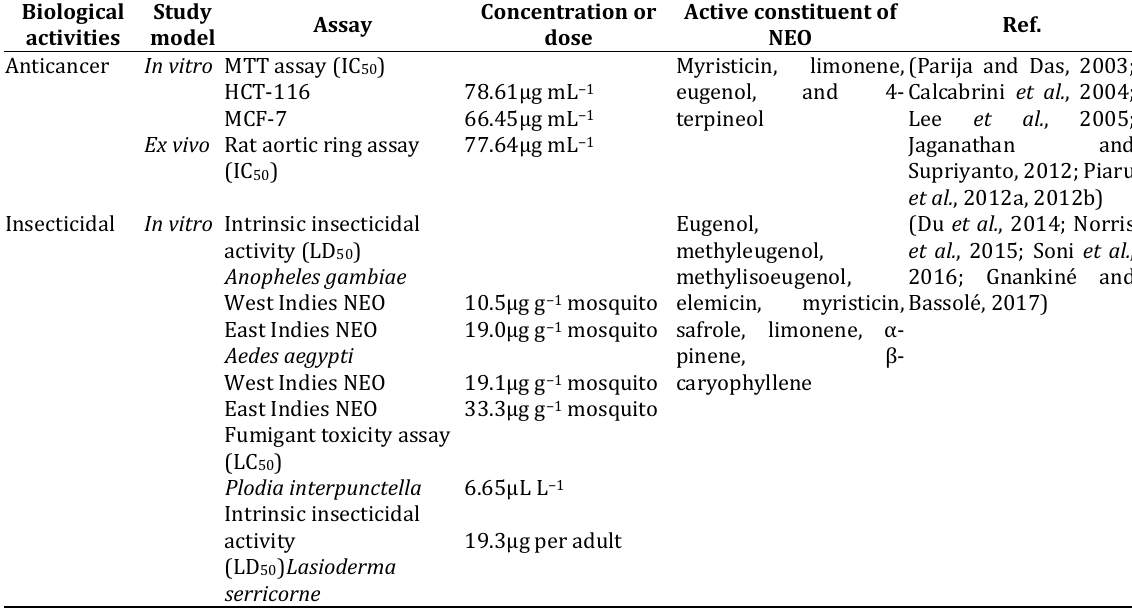
Table Ib. Myristica fragrans Houtt. essential oil bioactivities Biological